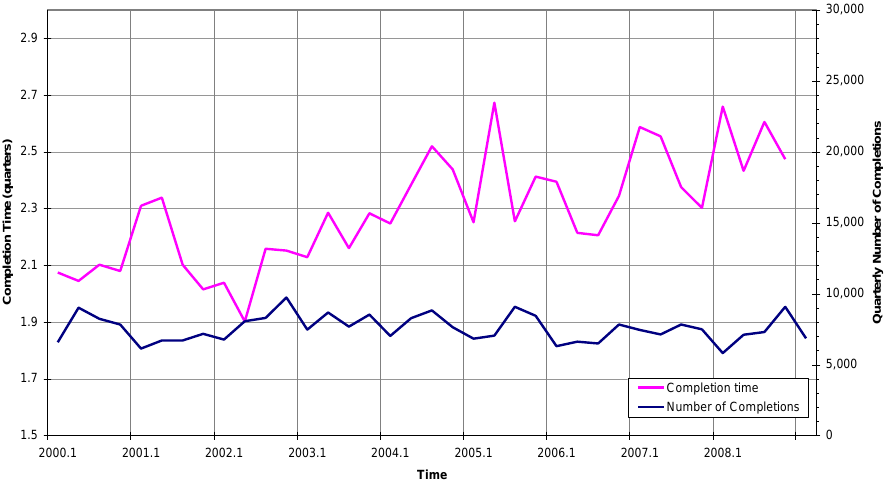
Figure 1: Average house completion time and quarterly number of completions in